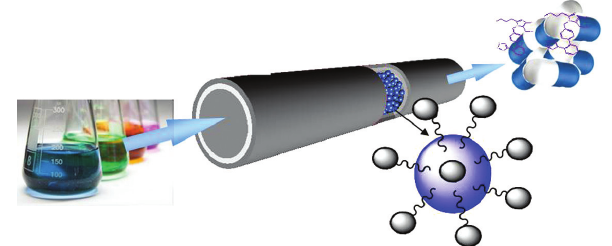
Figure 1 Scheme of the production of APIs in continuous flow